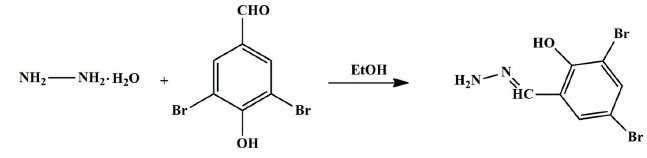
Figure 4 A reaction scheme showing the synthesis of the title